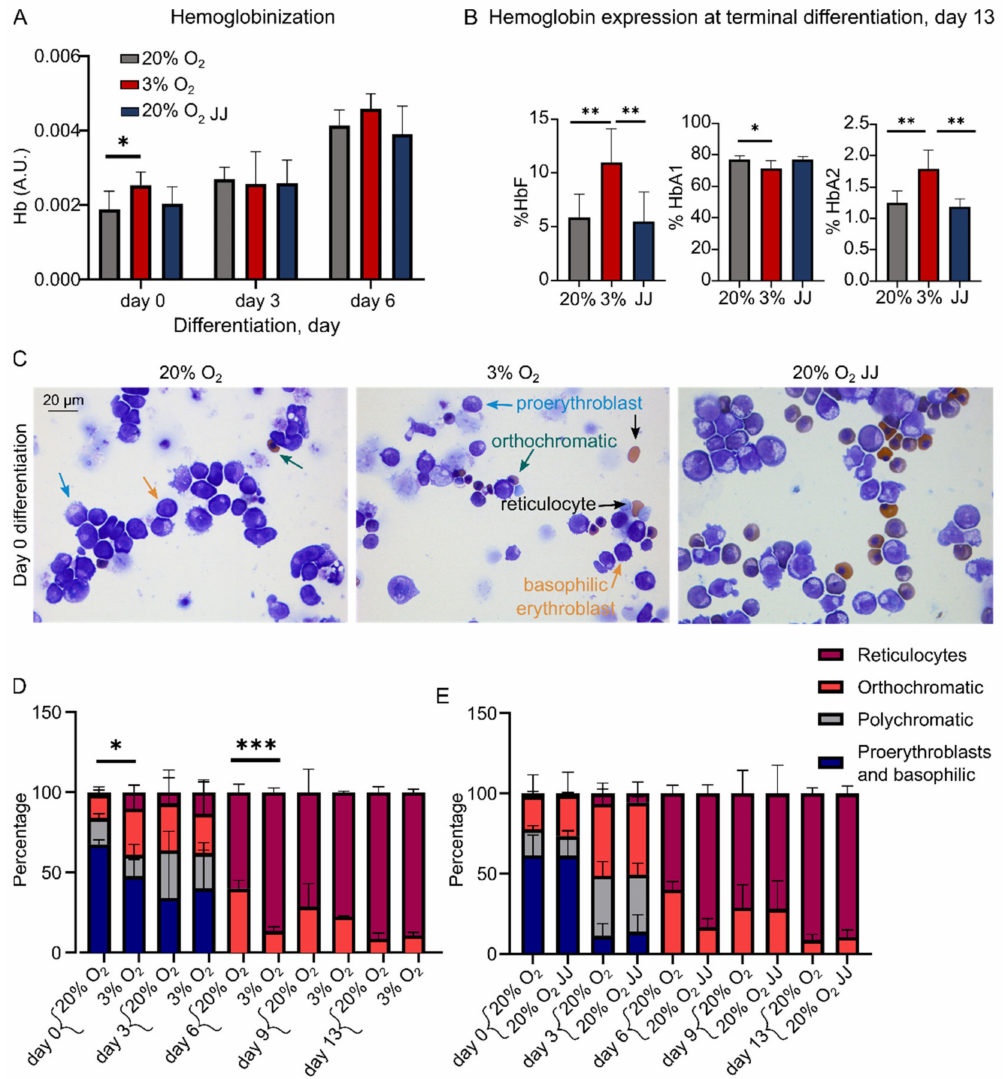
Figure 3. Hemoglobin expression is increased at onset of erythroblast differentiation with a changed globin composition. ( A ) Quantification of Hb levels determined by spectrophotometry (Materials and Methods) showed a significant increase at day 0 for cells at 3% O 2 . ( B ) HPLC analysis of hemoglobins at the end of differentiation (day 13). HbF expression was doubled in cells at 3% O 2 , reflected by a lower expression of HbA1. Moreover, HbA2 expression was retained in cultures performed at 3% O 2 . ( C ) Cytospins showed formed reticulocytes at 3% O 2 at day 0, when cells were still suspended in the expansion medium. Occasional orthochromatic erythroblasts were found in 20% O 2 and 20% O 2 JJ cultures. ( D ) Statistical analysis on such images revealed a higher number of formed reticulocytes at day 0 and day 6 differentiation on a count of about 300 cells per volunteer. ( E ) No differences were found between 20% O 2 and 20% O 2 JJ. * = p < 0.05, ** = p < 0.01 and *** = p <